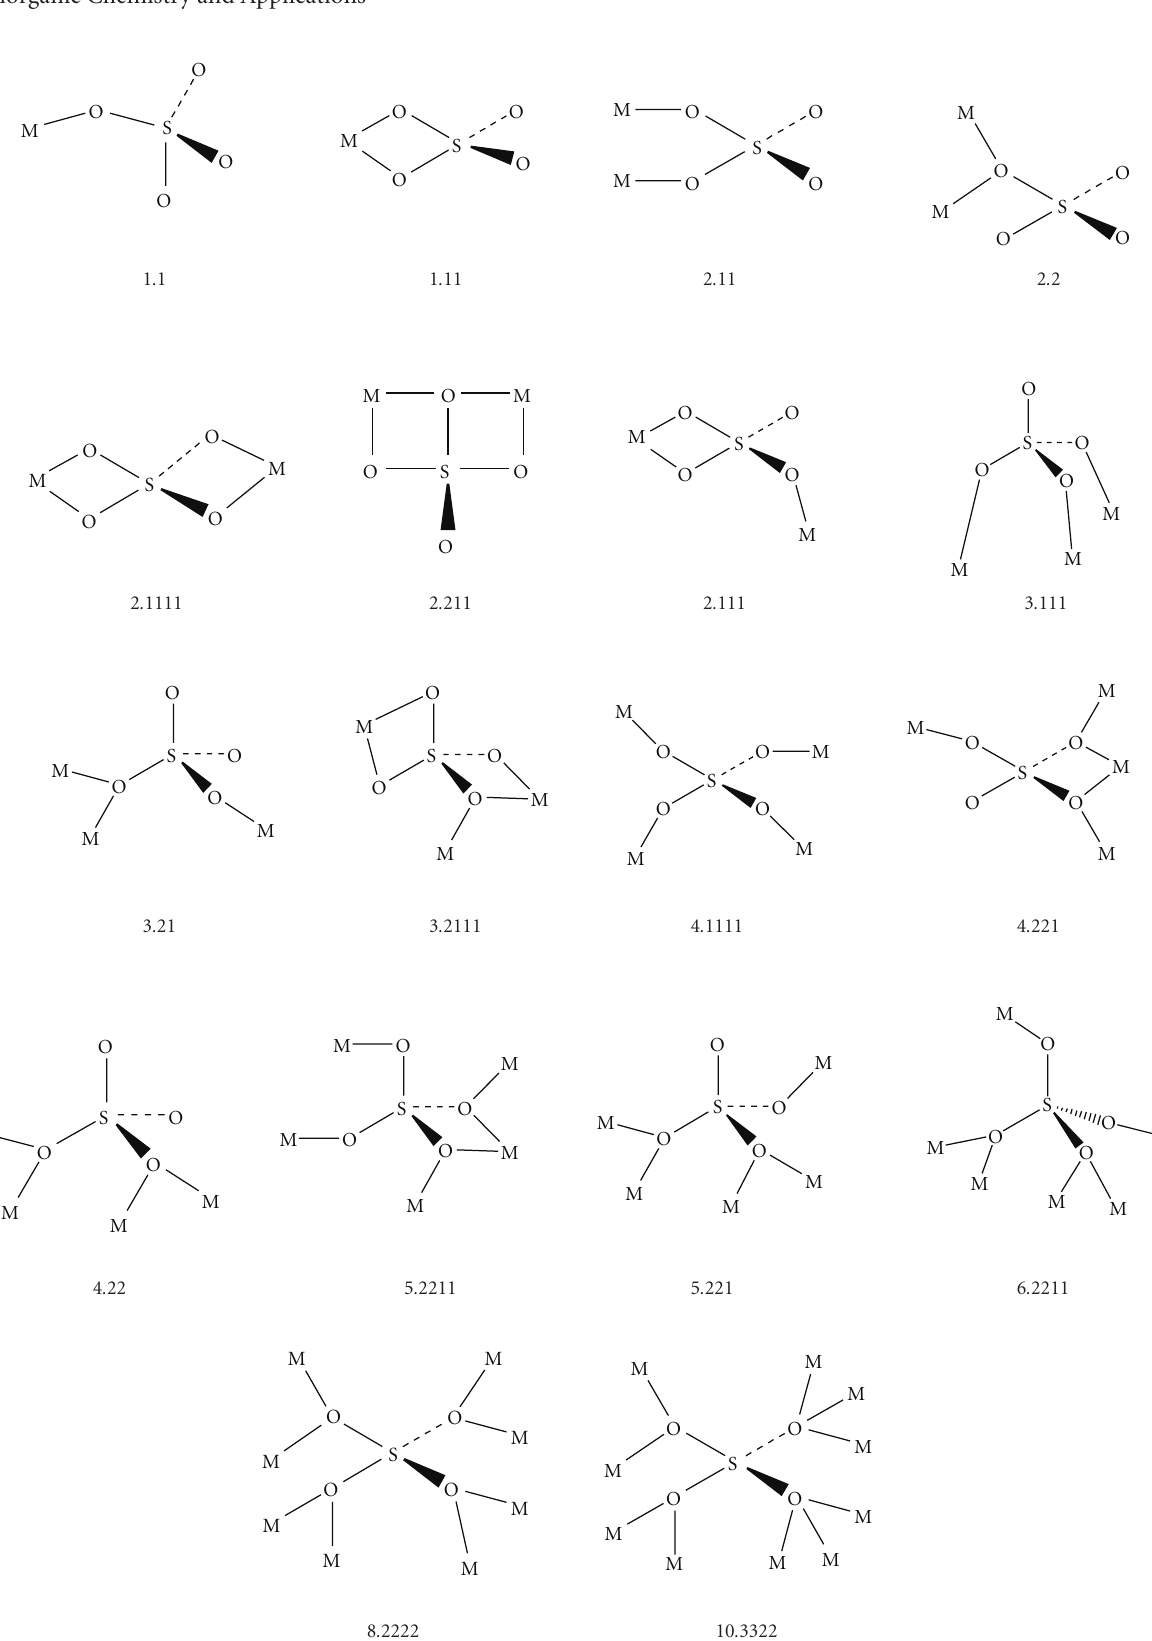
describes these